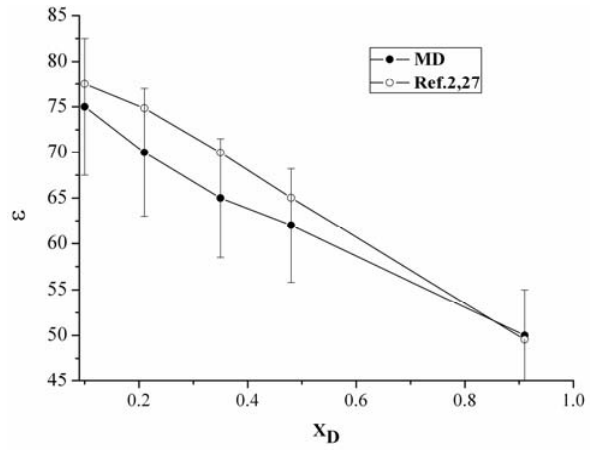
Figure 1. MD (full symbols) and Reference [2] and [27] (open symbols) data for the mixture’s dielectric constant vs. DMSO mole